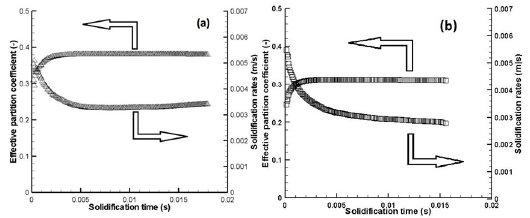
) and solidification rates ef